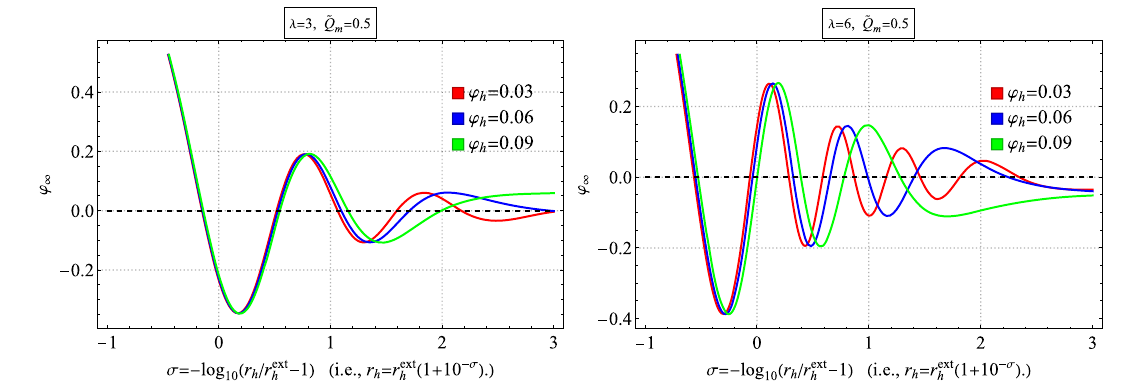
Fig. 4 Plots show the asymptotic value ϕ ∞ of the scalar field as a function of horizon radius r h for fixed coupling constant λ , reduced magnetic charge ˜ Q m and horizon-value ϕ h of the scalar field. Here we denote the extremal horizon radius r ext